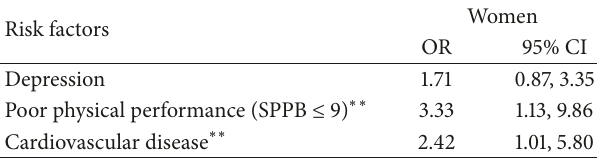
Figure 1: Proportions of men and women who reported falling across age groups.